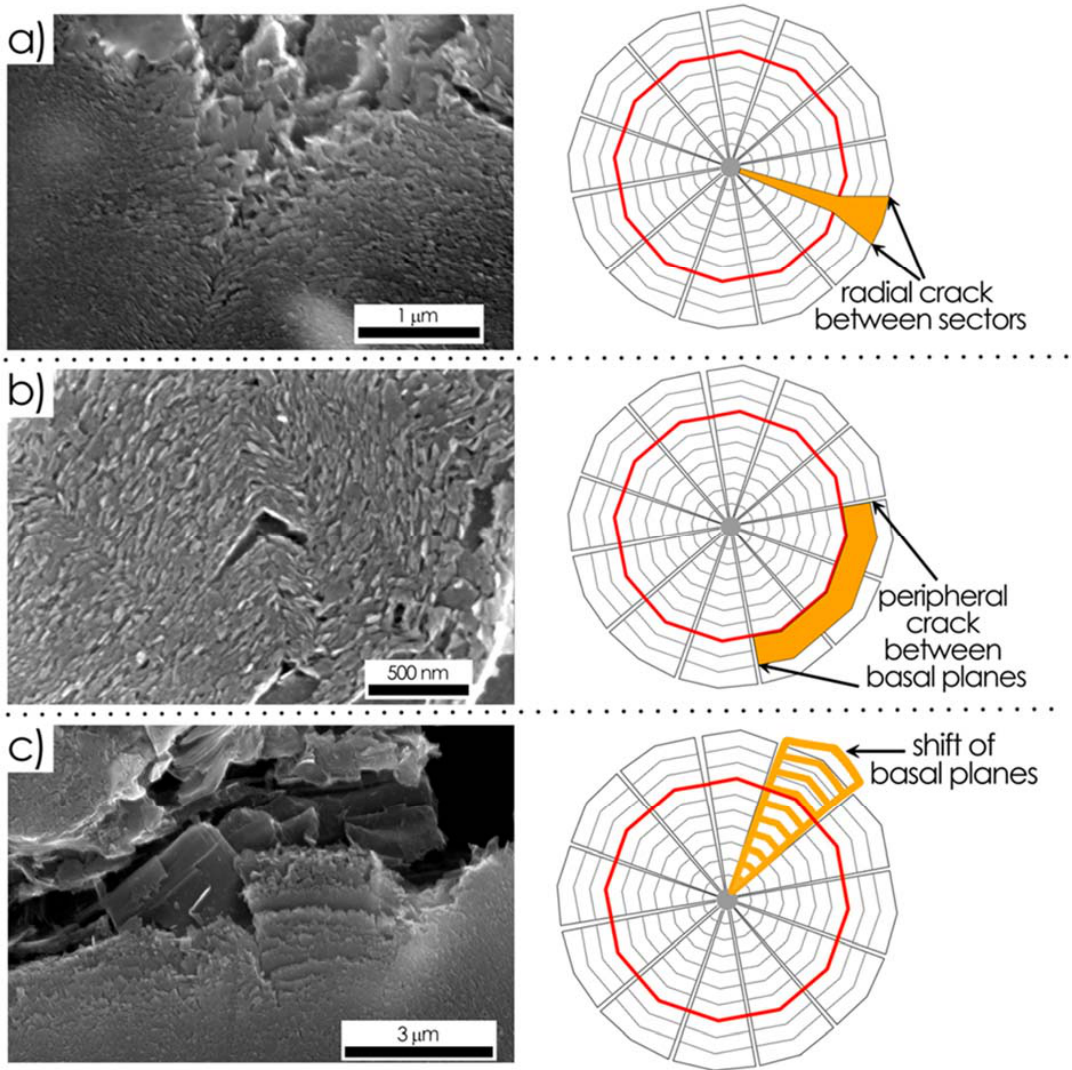
Figure 18. Internal damage effects in the graphite nodule due to tensile stresses: ( a ) Radial crack formation between particular sectors, ( b ) a peripheral crack initiated between basal planes in two neighboring sectors, ( c ) a displacement of the basal graphite plates combined with shift and rotation of basal graphite plates in particular sectors in the external rim.